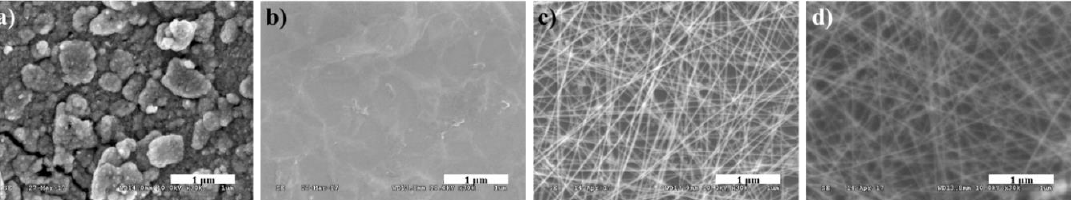
Figure 5. SEM images of fabricated electrodes: ( a ) Pt; ( b ) 5G; ( c ) 5G-4Ag; ( d ) P/(5G–4Ag).